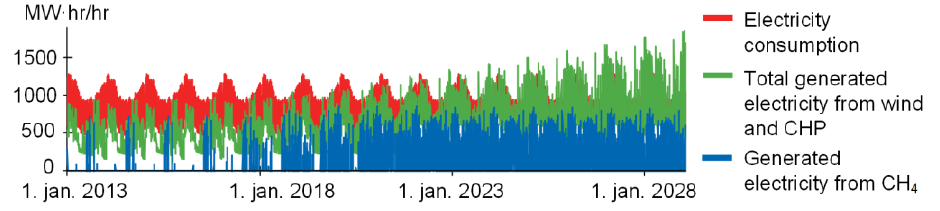
Fig. 6. The total balance of the electricity generated and electricity demand in first